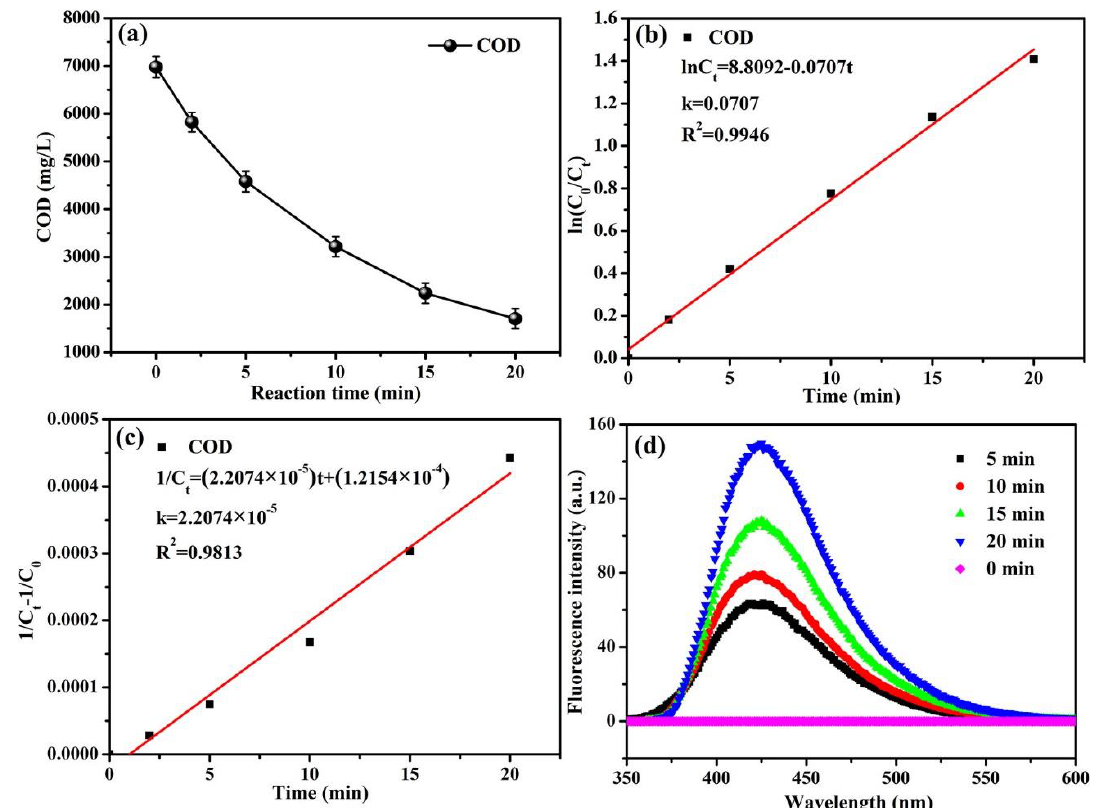
Figure 4. ( a ) The COD for different reaction times, ( b ) linear dependence of first-order reaction based on COD, ( c ) linear dependence of second-order reaction based on COD, and ( d ) fluorescence test for hydroxyl radicals measurement.